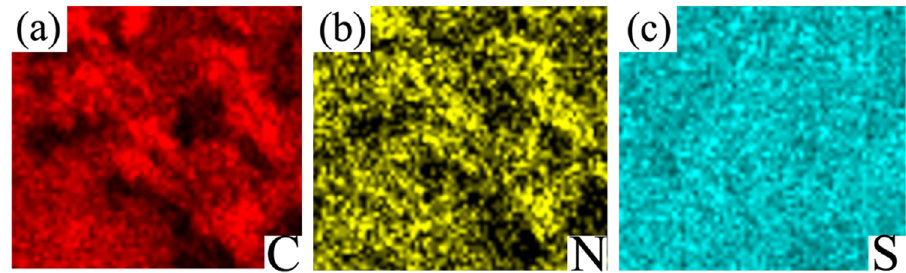
Figure A2: EDX elemental mapping images of ( a ) carbon, ( b ) nitrogen, and ( c ) S elements for TBrTh – BTBPE – CTF.